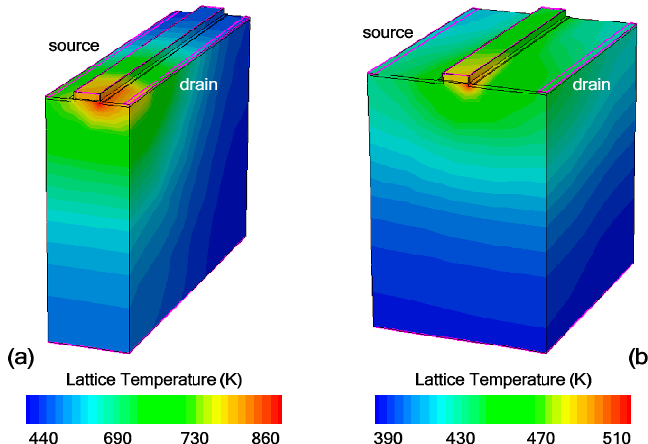
Figure 9. TLP I-V curves of SiGe S/D TFET with different SOP and DOP values.